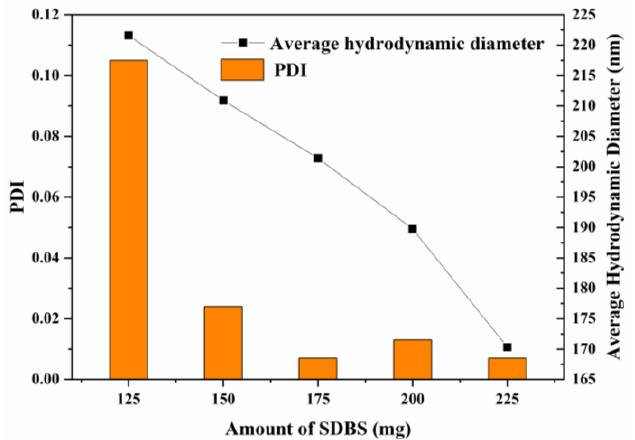
Figure 1. DLS characterization of the particle size of PSt microspheres synthesized with different amounts of SDBS. amounts of